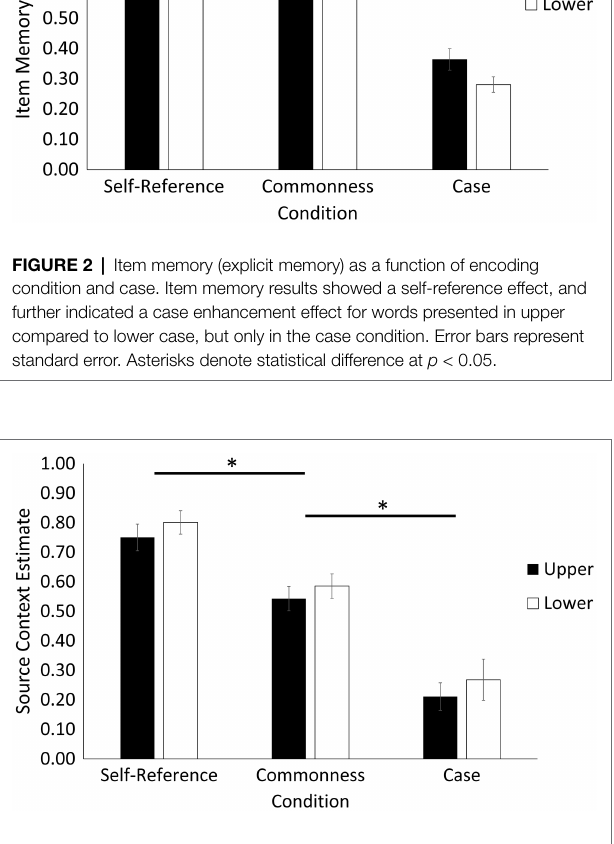
FIGURE 3 | Source context memory estimates (explicit memory) as a function of encoding condition and case. Results indicated a self-reference effect, and a case effect where memory was better for words presented in lower compared to upper case across all conditions. Error bars represent standard error. Asterisks denote statistical difference at p < 0.05.